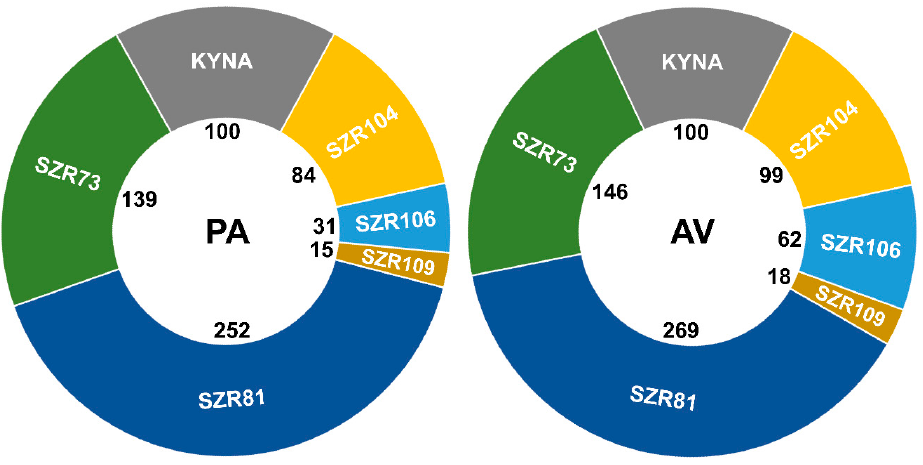
Molecules 2019 , 24 , x 5 of 10 stimulator [39], had no effect on survival ( P. acuticornis : 99%; A. vaga : 98%), while at the same time the number of rotifers significantly increased (Figure 4). However, the NaN 3 toxin [40] decreased survival ( P. acuticornis : 82%; A. vaga : 33%) and the total number of individuals. The reference point (Figures 2 and 4), day nine, was the lowest survival measured in the A. vaga population (Figure 4B). Spermidine (100 µM), a well-known calorie restriction mimetic [41], significantly increased survival ( P. acuticornis : 181%; A. vaga : 179%) and other parameters, similarly to KYNA and some of its derivatives. Henceforth, we tested how these profile-reference molecules affected the physiological characteristics of rotifers. All four parameters were positively elevated by cAMP induced stimulation (Figure 5A) in both species. In NaN 3 toxicity (Figure 5B) measurements, the parameters of interest showed uniform decrease. Antagonistic profiles were observed in spermidine-treated animals (Figure 5C), similarly to groups treated with KYNA or its analogs. The elevated NRA-BSI and the decreased CRC-MCF pairs appeared simultaneously with prolonged survival. The significant increase of slow-changing, time-consuming physiological markers (survival, NRA, BSI), together with the alteration of dynamic changing indicators (CRC and MCF) formed a specific physiological profile that we named beneficial physiologic attenuation (BPA). ‘Beneficial’ refers to the positive changes in survival, NRA and BSI, while ‘attenuation’ means the non-toxic type of decrease as in the case of CRC and MCF. The measured characteristics describe the energy-dependent life quality, covering both the chronic and acute alterations. Since, the exact mechanism of action of KYNA and its analogs is as yet unclear in rotifers, our objective in this present work was to describe the BPA phenomenon. We assumed that its molecular background might be related to serotonergic regulation [11] and redox modulation [15,38] in these particular bdelloids. Figure 4. Survival kinetics of rotifer populations treated (100 µM) with stimulator, toxin or calorie restriction mimetic. The number and survival of individuals significantly increased under spermidine treatment, compared to untreated controls. The cyclic adenosine monophosphate (cAMP) had a positive effect on the reproduction of individuals; however, it had no pronounced influence on the survival of animals. NaN 3 was toxic to both Philodina acuticornis ( A ) and Adineta vaga ( B ) species. The two different rotifer genera show similar kinetics under the same treatments. The error bars represent SEM. One-way ANOVA with Bonferroni post hoc test was used for statistical analysis, the level of significance is ***;### p < 0.001 (*, significant difference in number of rotifers from untreated controls on day nine; # significant difference from untreated controls in survival of animals; n = 12 wells). Figure 5. Biological characteristics of rotifers treated (100 µ M) with stimulator, toxin or calorie restriction mimetic having contradictory profile. On day six, three experimental- (NRA, BSI, MCF) and one chemical (CRC) parameter of individual rotifers and populations were monitored. All parameters show significant di ff erences from their untreated controls (shown as zero value on the x axis in graphs) in a positive direction evoked by cAMP ( A ) in contrast to NaN 3 ( B ). Spermidine ( C ) has an antagonistic profile related to the NRA-BSI compared to CRC-MCF pairs. These three types of treatments show di ff erent biological profiles (stimulation, toxicity and antagonism) in our rotifer models. The error bars represent SEM. One-way ANOVA with Bonferroni post hoc test was used for statistical analysis, the levels of significance are * p ≤ 0.05, ** p ≤ 0.01 and *** p ≤ 0.001. (*, significant di ff erence from untreated controls, where the corresponding data of 100% is the zero value on the x axis); NRA, n = 24 wells; BSI, n = 50 randomly selected individuals from 24 wells; CRC, n = 24 wells; MCF, n = 50 randomly selected individuals from 24 wells).